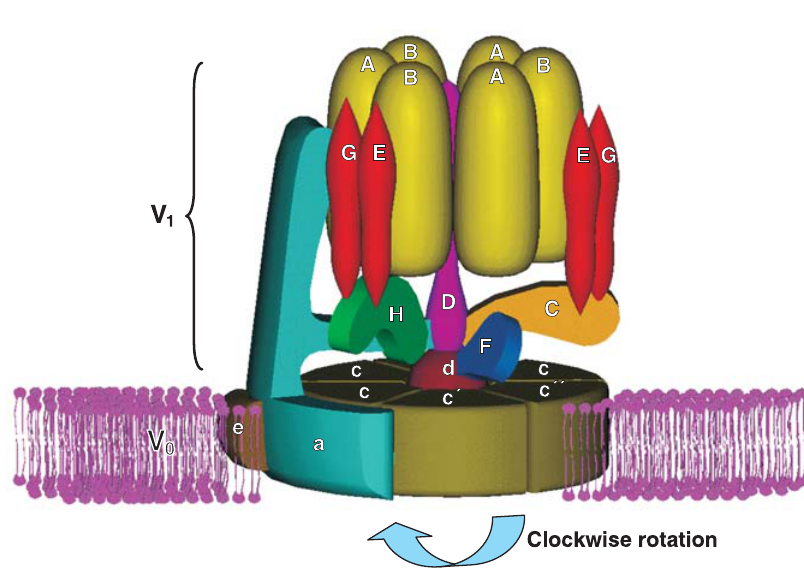
Figure 1. Model of vacuolar H + - ATPase. The V-ATPase complex is composed of a peripheral domain